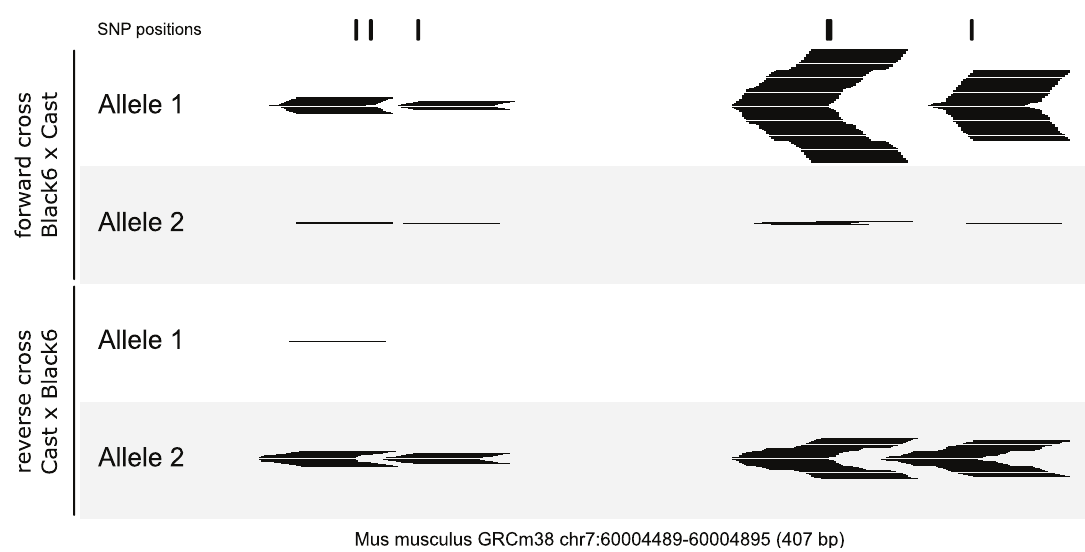
Figure 2. ChIP-Seq for the transcription factor ZFP57 identifies parental-origin allele-specific binding at the differentially methylated region (DMR) of the SNRPN locus. The binding of ZFB57 is methylation dependent and can be found exclusively on the maternal allele (genetic background of mother in forward cross: Black 6; mother in reverse cross: Cast). SNP positions were N-masked and used for allele- specific splitting of sequencing reads (shown as horizontal lines in black). Allele 1: Black 6 reference. Allele 2: Cast/EiJ strain (Cast). The area shown depicts the DMR only in part. Data taken from 17 (GEO accession: